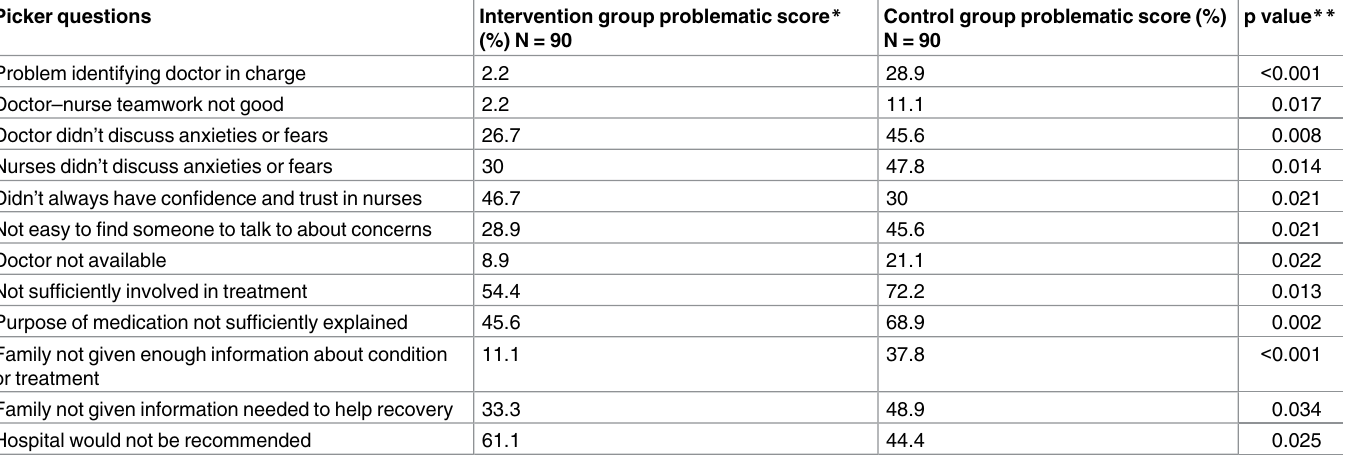
Table 1. Between-group differences in patient satisfaction as measuredby the Picker inpatient satisfaction